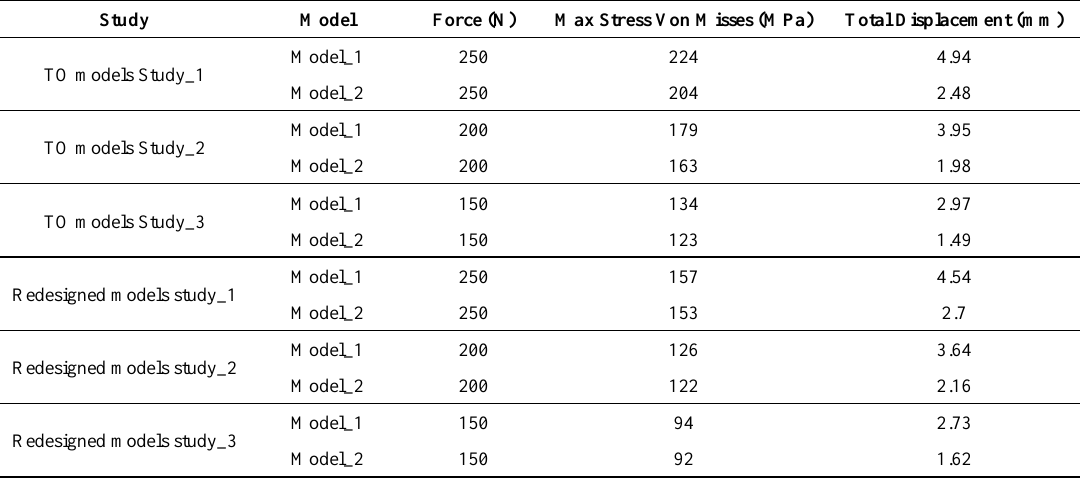
Table 2. Results of all six Finite Element